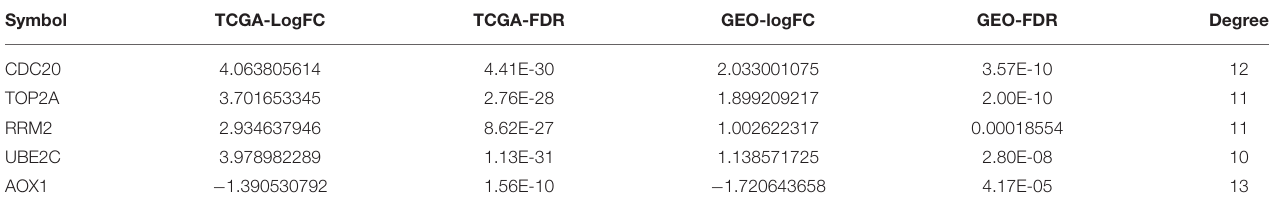
TABLE 3 | Expression difference of core genes and degree value.